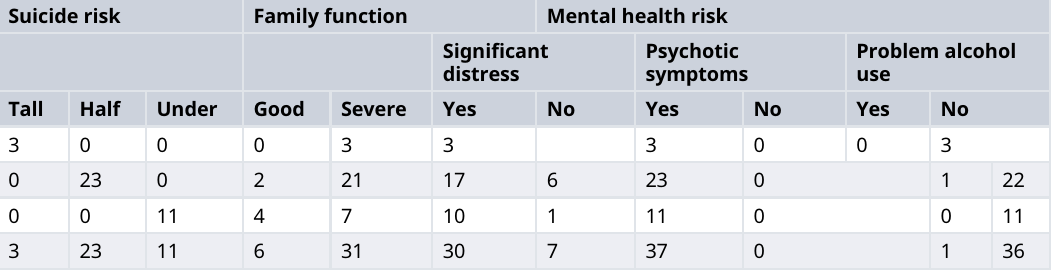
Table 2. Correlation of